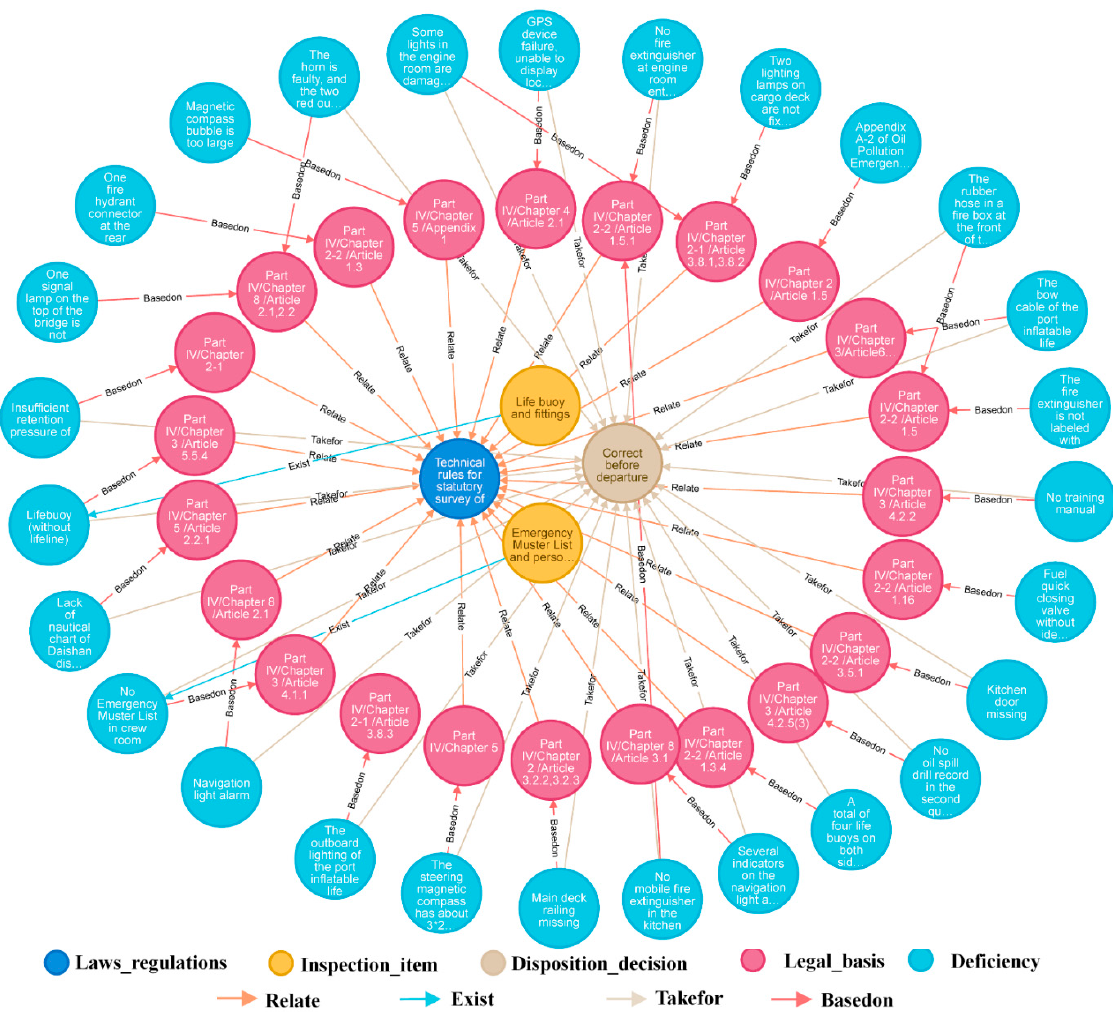
Figure 10. Ship inspection information